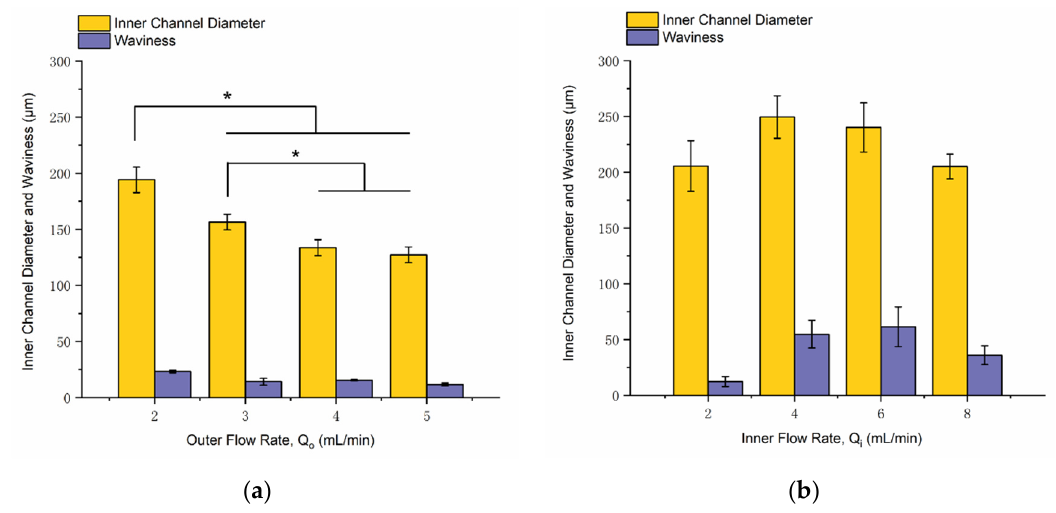
Figure 5. Effect of flow rate on channel dimensions of 3D-printed connectors: ( a ) the effect of outer flow rate under the same inner flow rate of 5 mL/min; ( b ) the effect of inner flow rate under the same outer flow rate of 2 mL/min ( n = 3, single asterisk (*) indicates significant differences between groups ( p < 0.05)).